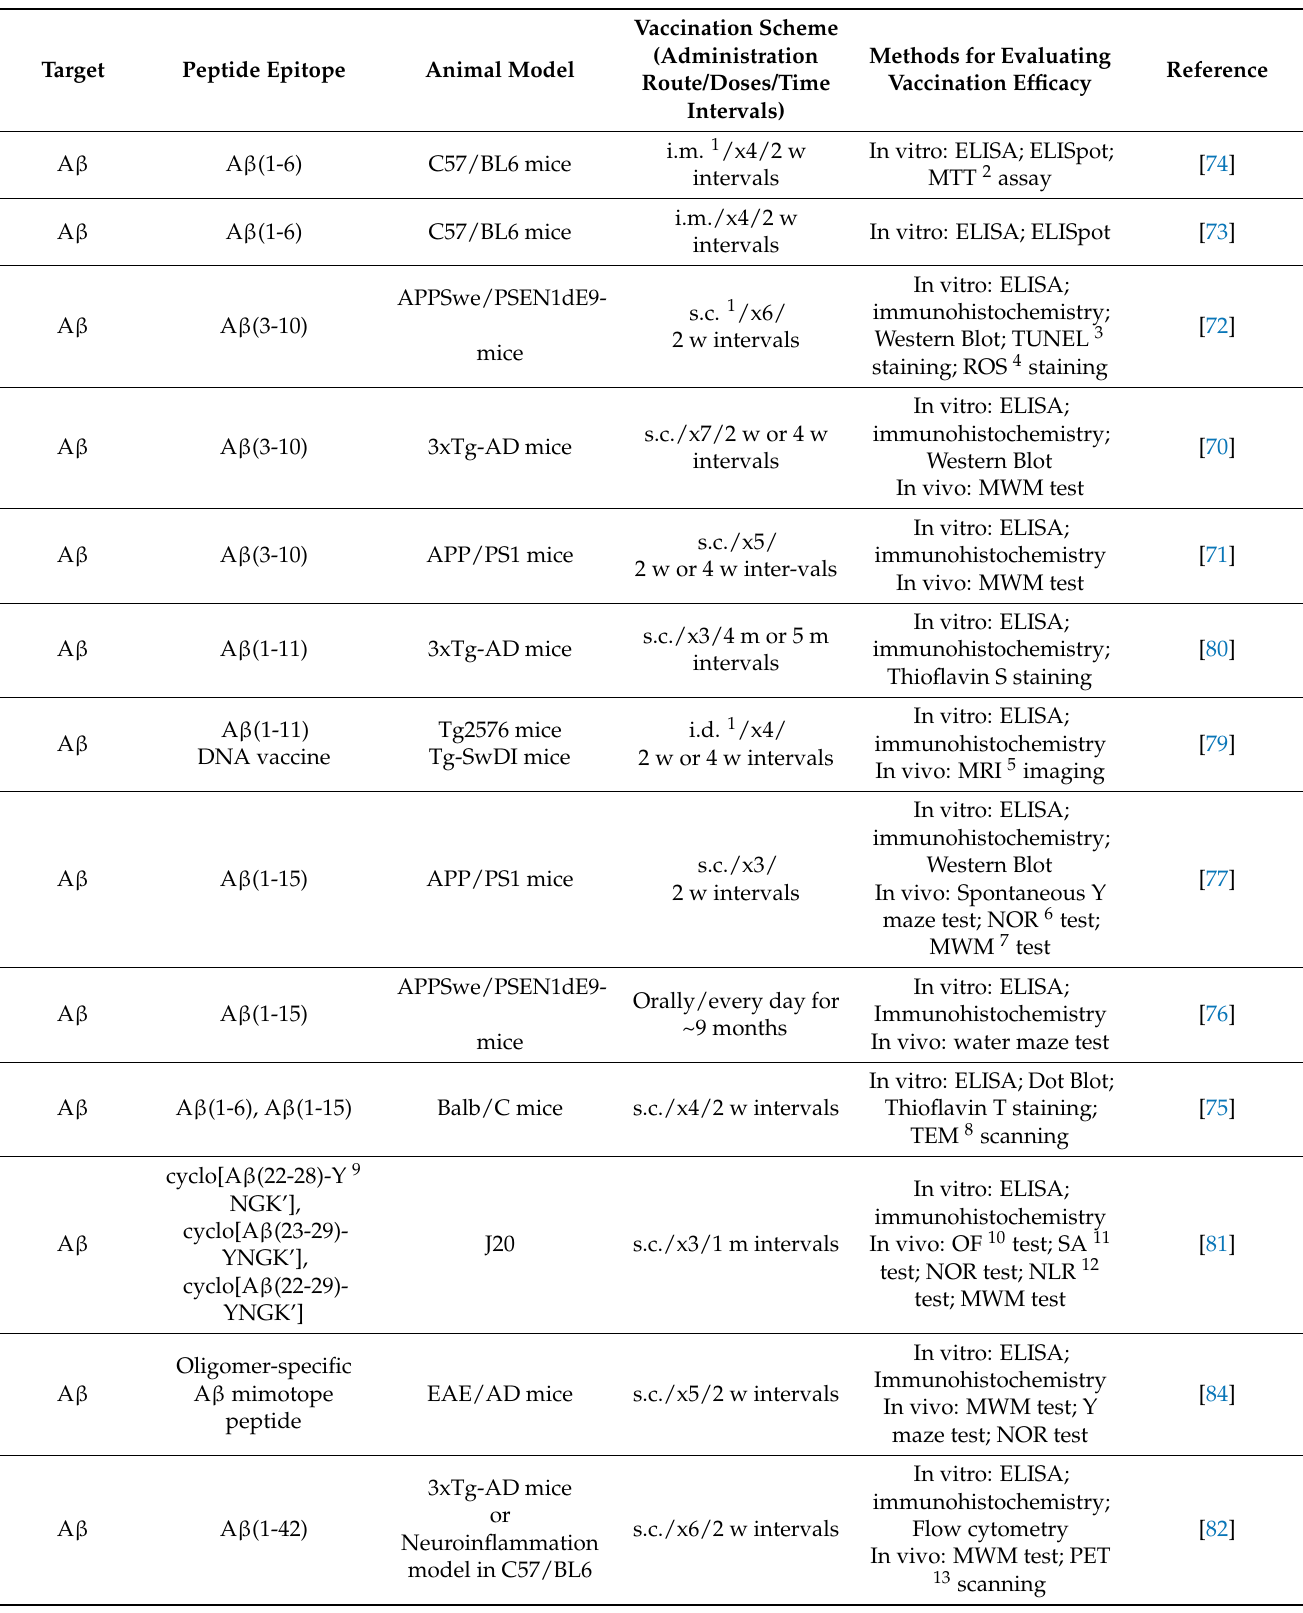
Table 2. Peptide-based A β -, tau-, and α -syn vaccines for neurodegenerative diseases: Animal models, vaccination schemes and methods for evaluating efficacy reported in recent preclinical